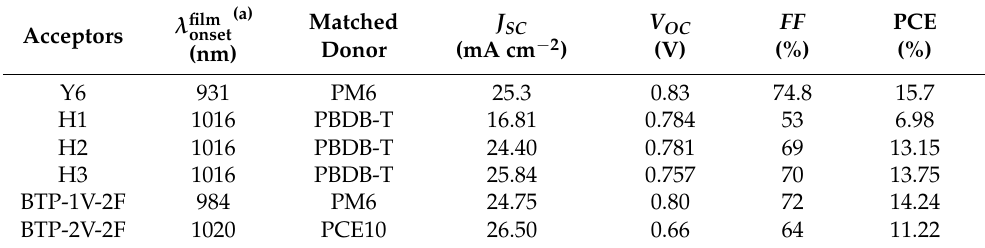
Table 2. Absorption and photovoltaic properties of Y6, H1, H2, H3, BTP-1V-2F, and BTP-2V-2F [78]. Data from Refs.